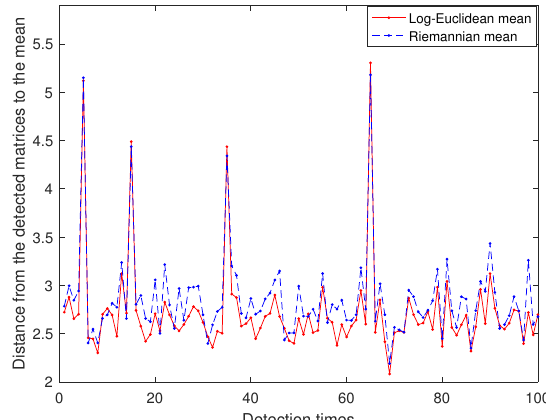
Figure 6. Distance from the detected matrices to the mean.